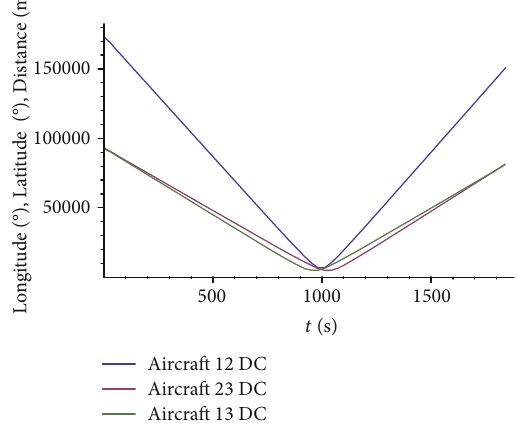
Figure 11: Experiment 2. Distance among aircraft with distance- based separation constraints (DC).